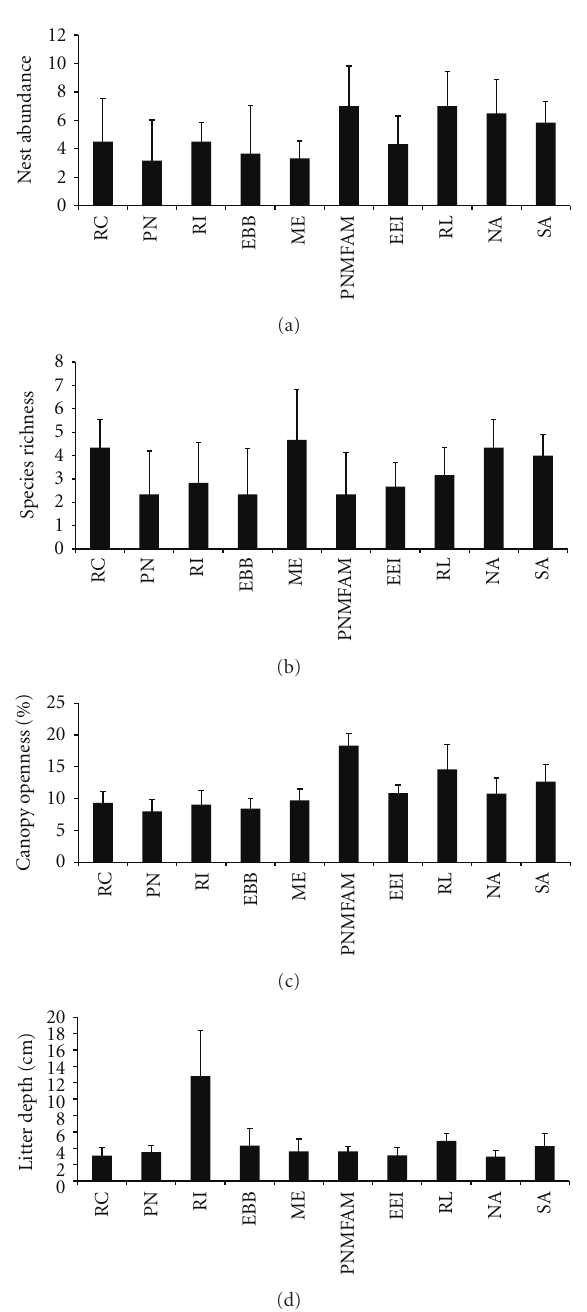
Figure 2: Average number of nests ± S.D. (a), species (b), canopy openness (c), and litter depth (d) of the sampled dense ombrophi- lous forest fragments.